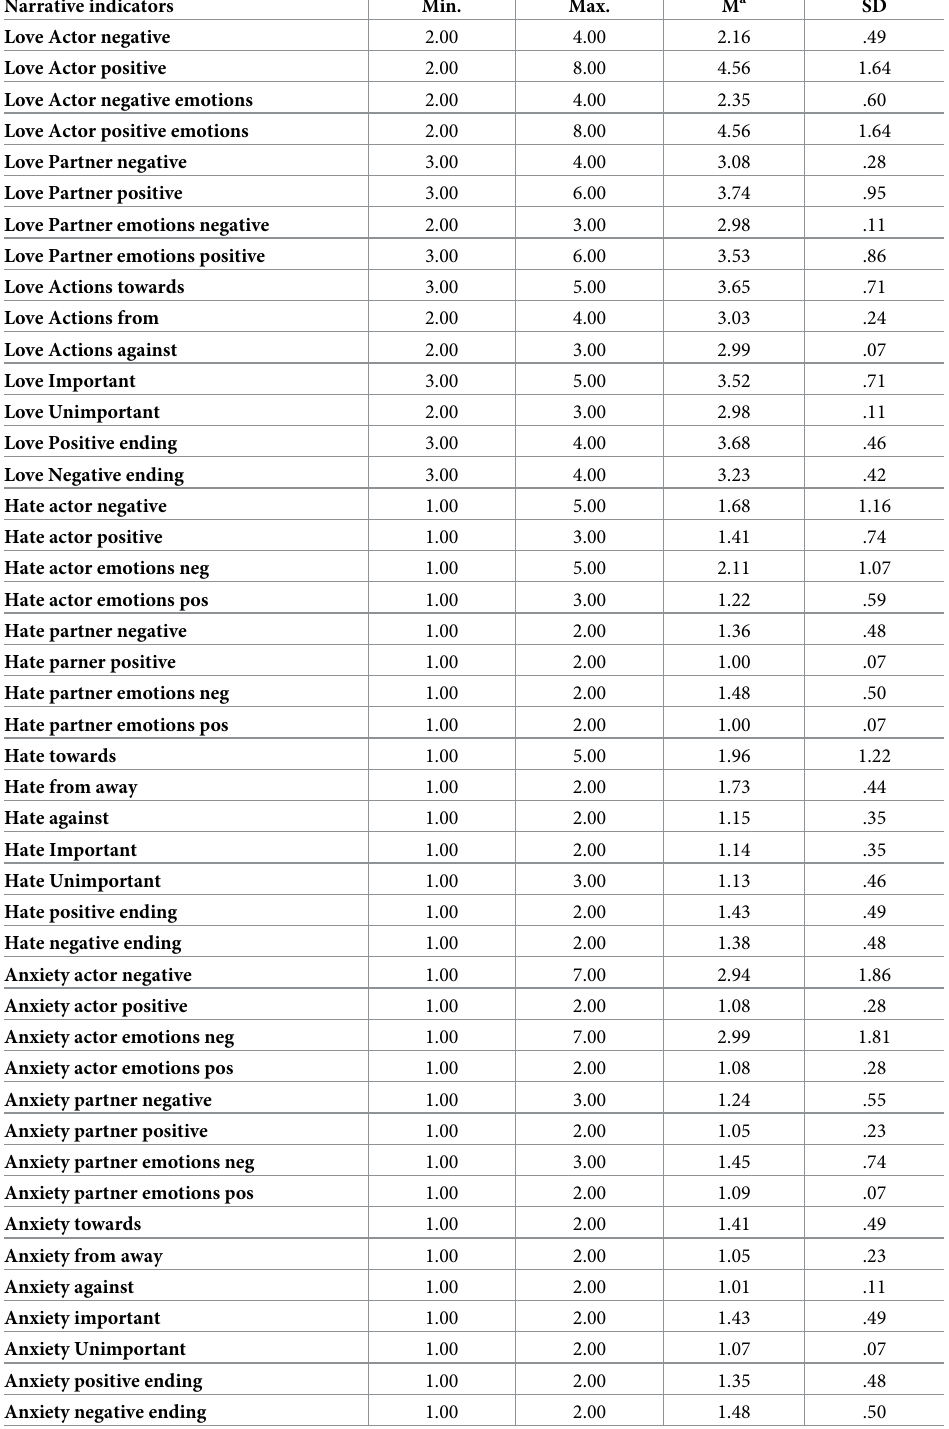
Table 2. Descriptive statistics: For love, hate, anxiety scripts ( n = 200). Narrative